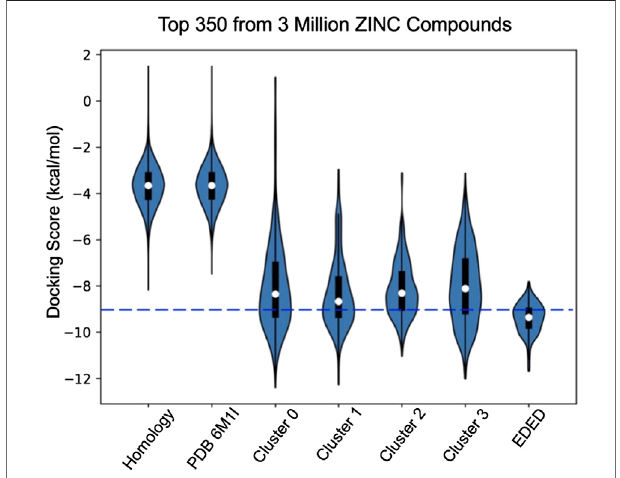
FIGURE 3 | Violin plots of the docking score distribution of the top 350 compounds to different receptor models. The dash line shows the – 9.0 kcal/ mol cutoff used to prioritize compounds for